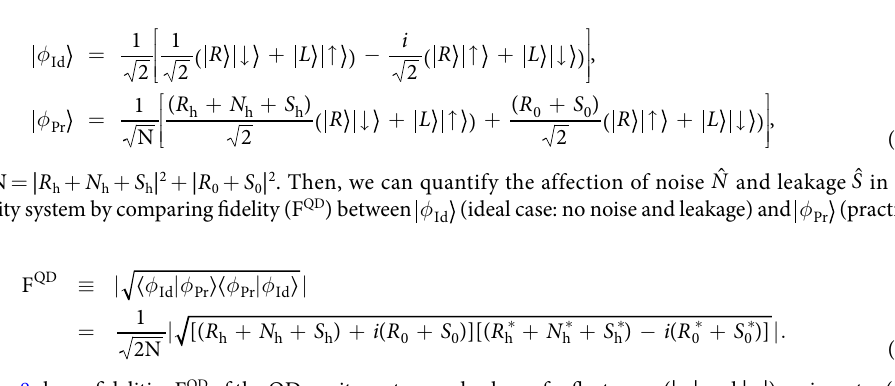
Figure 8 shows fidelities F QD of the QD-cavity system and values of reflectances (| r h | and | r 0 |), noise rates (| n h | and | n 0 |), leakage rates (| s h | and | s 0 |), and phase shifts ( φ rh , φ r0 , φ nh , φ n0 , φ sh , and φ s0 ) for κ s / κ and g / κ with fixed = κ /2. In our analysis 4,20 , when the QD-cavity system has experimental parameters g ≫ ( κ , γ / κ = 0.1 and ω − ω c κ with small γ 47,65–68 and ω γ ) and κ s ≪ Table, if experimental parameters are κ s = 0.01 and g / κ = 2.5 with γ / κ = 0.1 and ω − ω c = κ /2, we can obtain high the Table. Namely, the affections of vacuum noise ˆ N on dipole interaction and leaky modes ˆ S and absorption) in cavity mode can be reduced by choosing parameters g ≫ ( κ , γ ) (strong coupling) and κ s ≪ κ (small side leakage) 4,20 for reliable interaction, parity operation, of the QD-cavity system. Consequently, we can achieve high efficiency and reliable performance (high fidelity by reducing affection of noise and leakage, as described in Fig. 8) of the QD-cavity system, in practice, to choose strong coupling strength g ≫ ( κ , γ ) and small side leakage κ s ≪ κ in optical cavity for parity gate in our scheme (generation of W state).